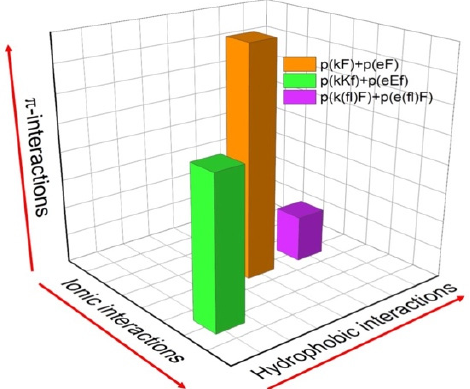
Figure 1. Relative comparison of the different molecular interactions present in the designed peptide sequence pairs. The magnitudes of each interaction (hydrophobic, ionic, and π -interactions) are approximate for the sake of comparison.